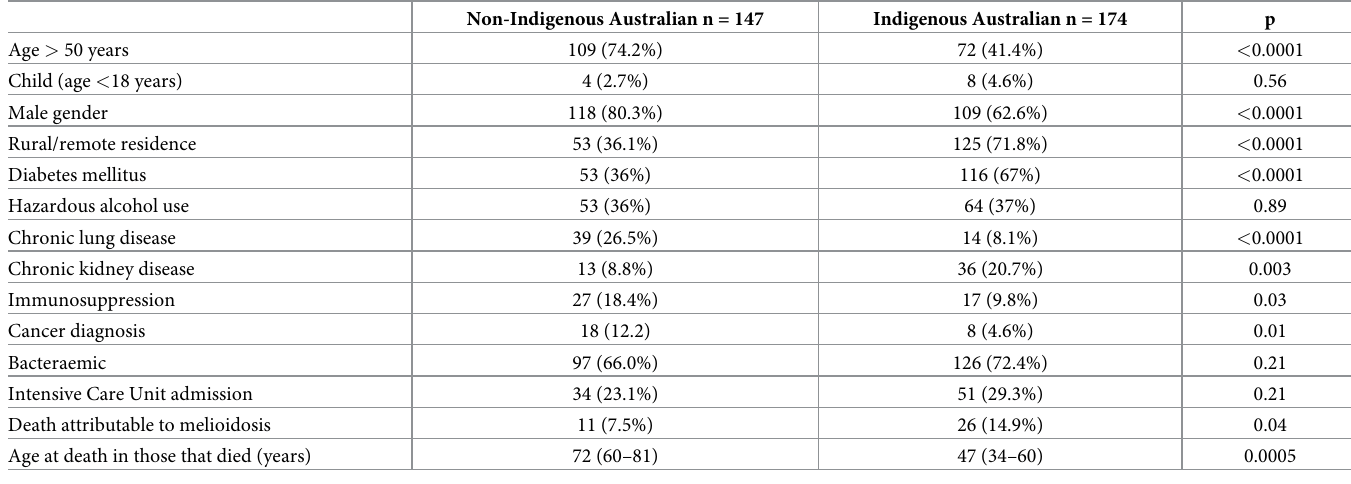
Table 3. Selected characteristics of the cohort stratified by Indigenous status.